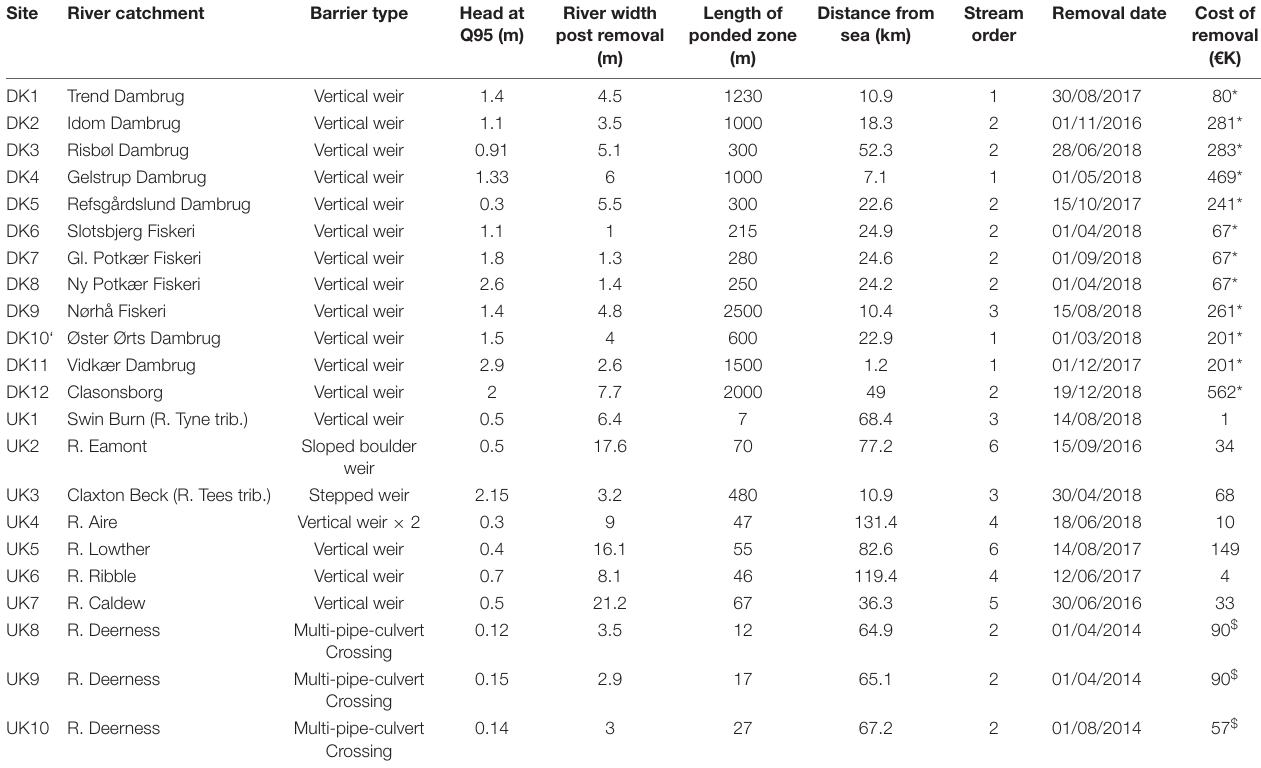
TABLE 1 | Site characteristics and details of barriers